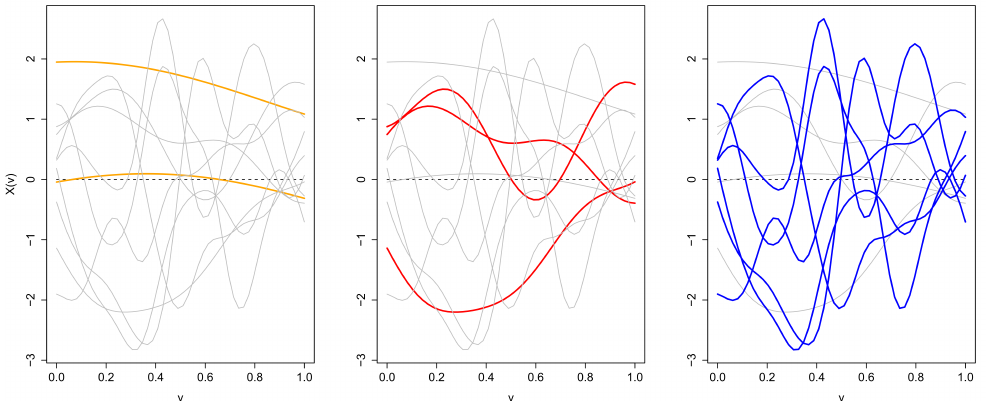
Figure 2. Observations from a mixture of Gaussian processes on [0,1]. Mixture components are mean zero and have covariance structure Cov ( s , t ) = exp {− ( s − t ) 2 / ( 2 m 2 ) } where m = 1 with probability 0.2, m = 0.25 with probability 0.3 and m = 0.1 with probability 0.5. Realizations corresponding to each mixture component are highlighted in the respective panels from left ( m = 1) to right ( m =